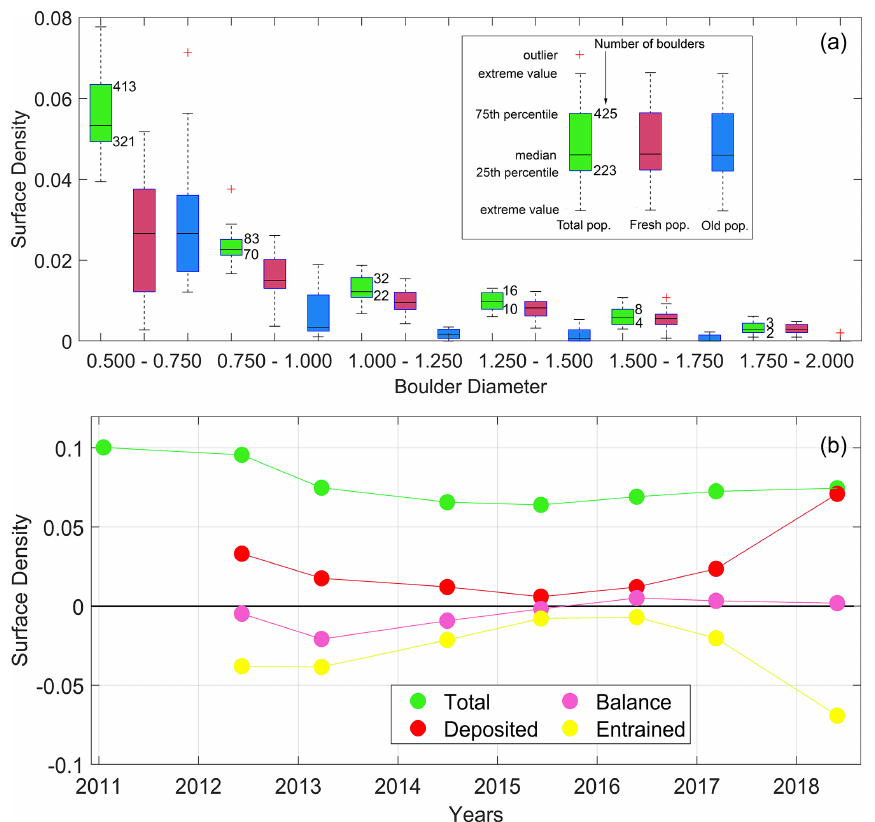
Figure 4. (a) Box plot of the dimensionless surface density of boulders (Eq. 1) at the surface of the bar as a function of their diameter, computed over the whole survey. Green: total number of boulders; red: freshly deposited boulders; green: boulders already in place during the previous campaign of observation. (b) Surface density of entrained (yellow), deposited (red) and total (green) boulder population. Balance between deposited and entrained boulder population in pink. Data from 2011 have been obtained from a preliminary campaign. Entrained boulders are counted negatively as they have been entrained out of the bar. Purple dots show the balance between entrained and deposited boulders.